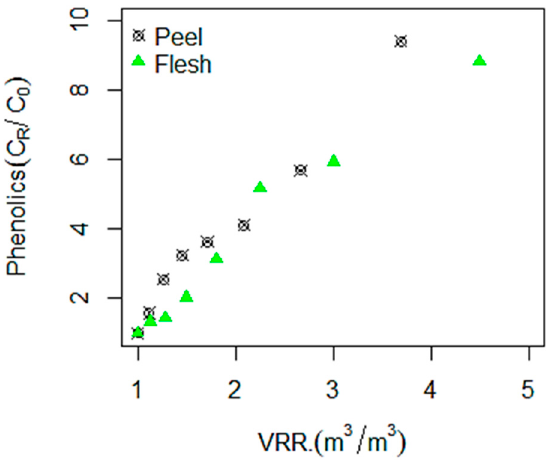
Figure 2. Variation of TPC with VRR during concentration by RO membrane (X20). AA in beetroot peel and flesh extracts were recorded as 6.5 ± 0.09 mg ASE · g − 1 dm and 1.00 ± 0.04 mg ASE · g − 1 dm, respectively (Table 1). It went up to 24.65 ± 1.42 mg ASE · g − 1 dm for peel extract, and 11.6 ± 0.1 mg ASE · g − 1 dm for flesh extract at the end of membrane filtration. Antioxidant component in each sample along with VRR is presented in Figure 3. It is noted that the CR of antioxidant content for both peel and flesh extracts are increased drastically with increase of VRR. CR for antioxidant for beetroot peel and flesh were 3.8 and 11.6, respectively, at the end of filtration.